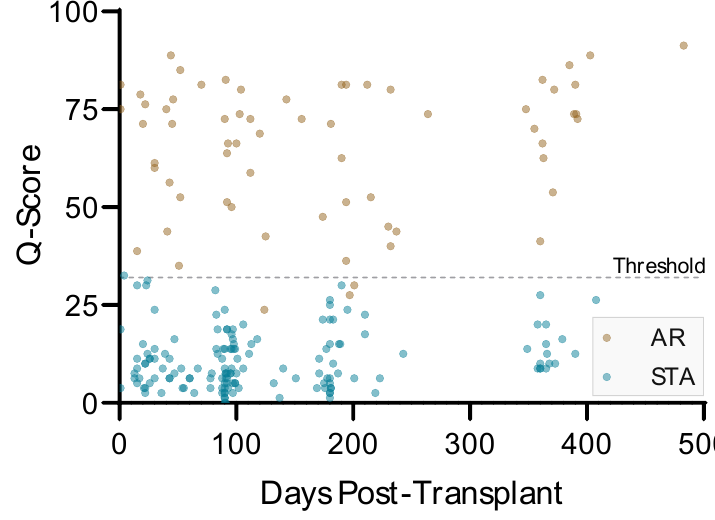
Figure 6. QSant can detect AR regardless of the time of development of acute rejection. The graph illustrates the Q-Score of each study patient and time from transplantation date to biopsy/sample collection date. Eight points beyond 500 days post-transplant are not shown in the graph. The data show that the QSant test can be used effectively in renal transplant patients 1 day after the procedure without the need to wait for the individual biomarkers to fall to their individual post-transplant stable steady-state levels post-transplantation.